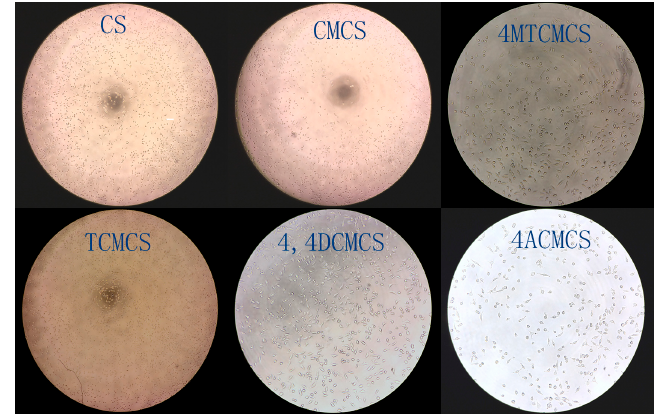
Figure 8. The sample concentration in the cell growth pictures was 500 µ g / mL.